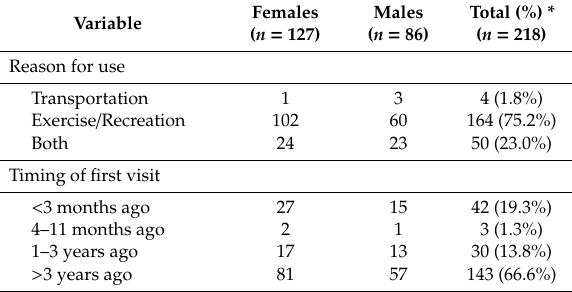
Table 3. Self-reported information on trail